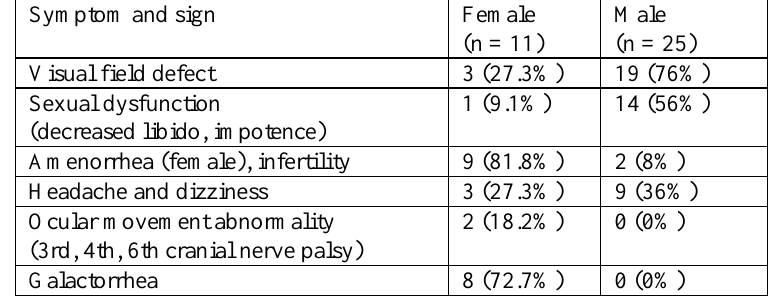
Table 1 Clinical manifestations in 36 patients with invasive prolactinomas Symptom and